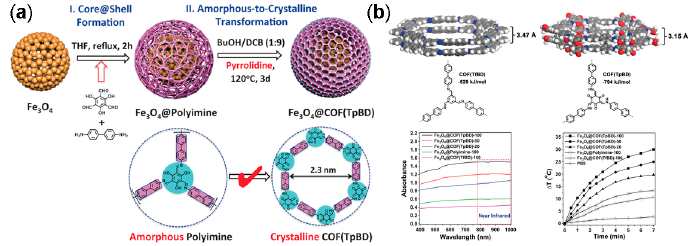
Figure 13. Schematic representations of preparation ( a ) and photothermal effect ( b ) of Fe 3 O 4 @COF. Reproduced with permission from [193]. Copyright John Wiley and Sons, 2016.